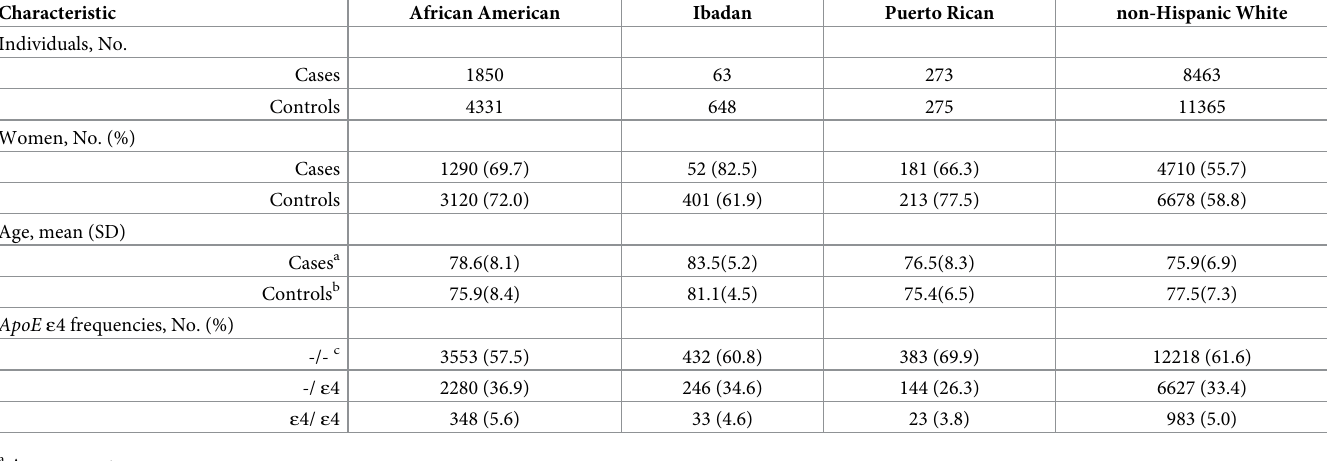
Table 3. Characteristics of African American, Ibadan, Puerto Rican, and non-Hispanic White data sets.